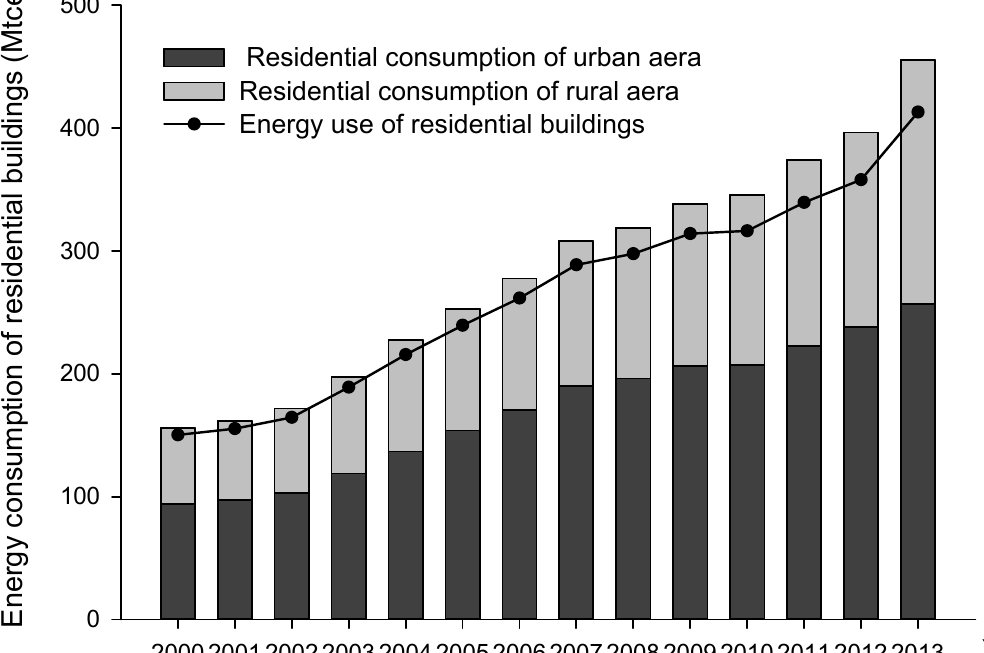
Figure 3. The energy use of residential buildings in China during